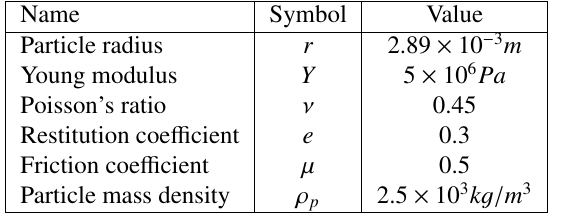
Figure 2: Distributions of the pressure per particle p clas- sified by the number of contacts z . Solid lines are the k- gamma distributions with k f and α computed from Eq. (9), while dotted lines are least squares fittings to a k-gamma function (left). Number of elementary forces k f (circles) and average pressure per grain (cid:104) p (cid:105) times the angoricity α − 1 (squares) as functions of z (right).